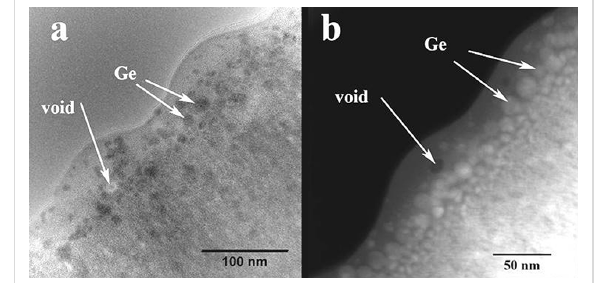
Figure 4: Morphology details of the GeTiO film surface layer structure revealed by the cross sectional observations. (a) XTEM conventional image and (b) a similar area viewed by STEM-HAADF